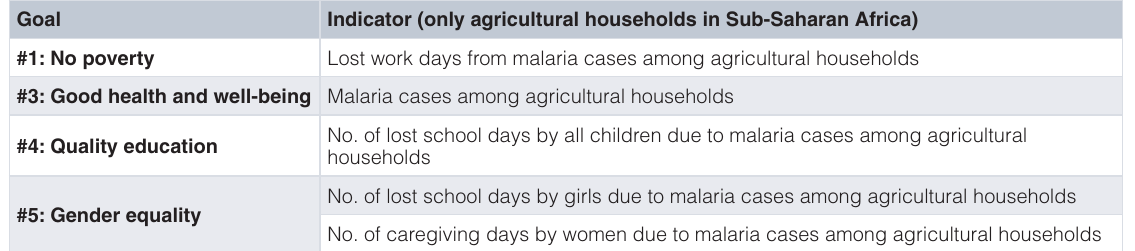
Table 2. Indicators for evaluating impact of suppressing malaria among agricultural households on the relevant Sustainable Development Goals. Goal